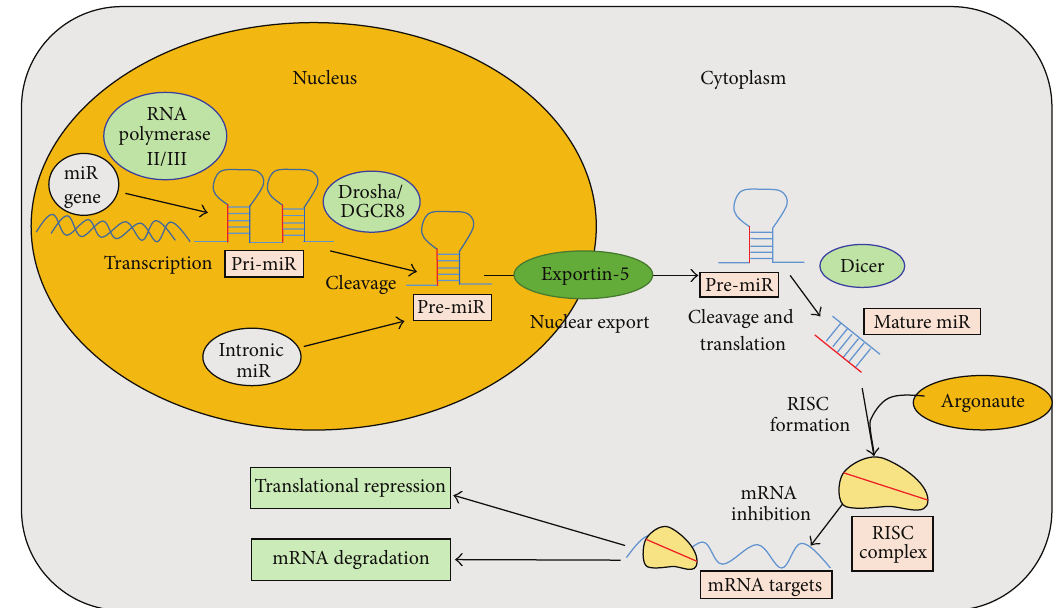
Figure 1: Schematic diagram illustrating the biogenesis of microRNAs (miRs). The diagram outlines this process from the initial transcription of miR genes or processing of intronic miRs in the nucleus until the formation of double-stranded, mature miRs in the cytoplasm, and their eventual inhibition/repression of target